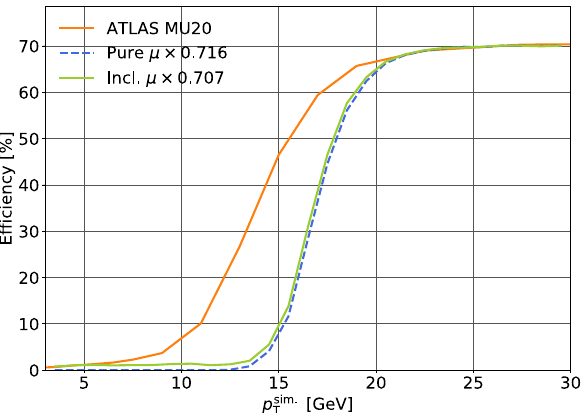
Fig. 8 Efficiency of selecting muon candidates plotted as a function of the muon p T . Shown in orange is the ATLAS data efficiency for the MU20 trigger threshold of the present RPC detector [20]. Shown in green (blue) is efficiency for selecting simulated muons with (without) noise hits. These two curves are scaled to obtain the same efficiency as the MU20 trigger for p T > 25 GeV